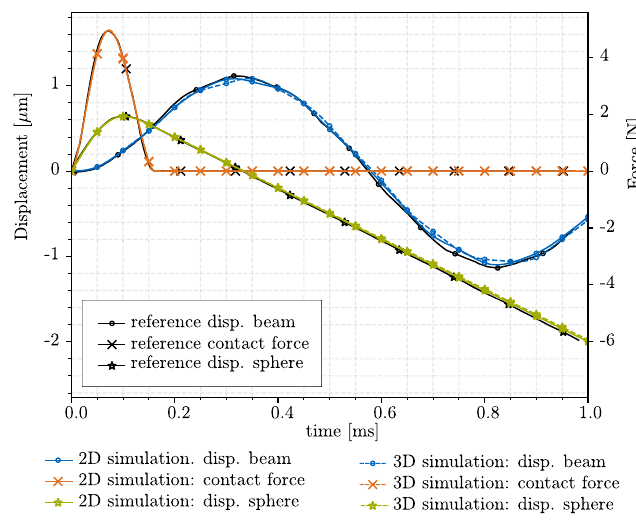
Fig. 7 Single spanned beam with a total length of 15 . 35cm hit laterally at its center by a sphere with radius R = 1cm. Numerical results for 2D and 3D simulation in comparison to reference solution [70]